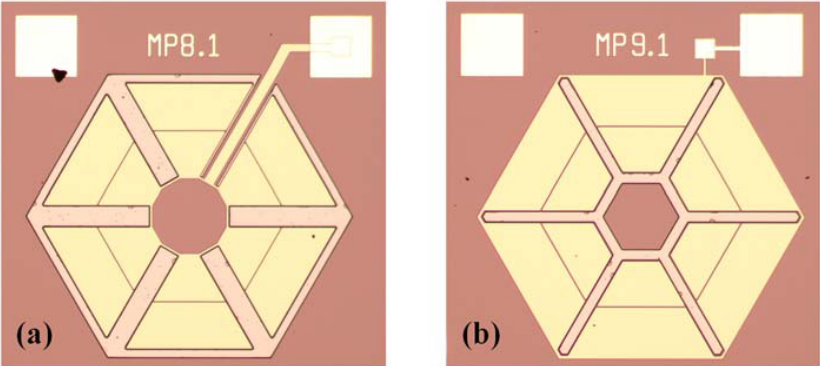
Figure 3. Schematic illustrations of the proposed piezoelectric MEMS accelerometer fabrication flow.